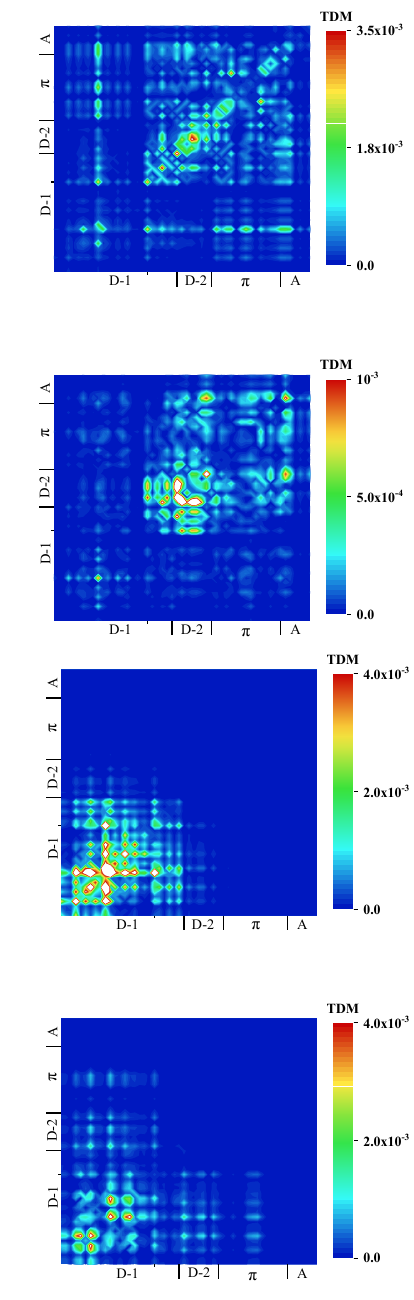
Figure 9. TDM and CDD of WS5 in TPA. TDM and CDD of S 0 → S 4 ( a ) of WS5, TDM and CDD of S 4 → S 17 ( b ) of WS5, TDM and CDD of S 0 → S 5 ( c ) of WS5, TDM and CDD of S 5 → S 18 ( d ) of WS5. As for the second step, S 4 → S 17 , it can be seen from Figure 9b that there was charge transfer between these four parts, among which the charge transfer between triphenylamine The TPA spectrum of WS6 had many absorption peaks, and its absorption range was and the π -linker and A was relatively weak. The CDD showed a blue isosurface on relatively wide. S 12 and S 9 , which constituted the strongest absorption peak, and S 4 , which the π - linker and A and a green isosurface on the triphenylamine, while the inserted D had a larger absorption cross-section, were mainly analyzed. For the excited state of S 4 , it (thiazolo[5,4-d]thiazole) was blue-green, indicating that the electron transfer from the π - had S 1 and S 3 as intermediate states. According to the previous analysis, the first step of linker and A to thiazolo[5,4-d]thiazole and then to triphenylamine was a sequential charge transfer. The second process was the reverse transfer of electrons, which was opposite to the first channel, S 0 → S 1 , was mainly the charge transfer in the A direction. The second the direction of charge transfer in the first process, indicating that the two-photon excited process was the reverse transfer of electrons to triphenylamine, as shown in Figure 10a. state of S 17 was a locally excited state. The TDM and CDD of S 18 are shown in The TDM indicated that the inserted D (bithiophene) not only had charge transfer with the π -linker, but also with the benzene ring on the inner side of triphenylamine. The CDD showed that the isosurface of the charge on the benzene ring on the inner side of triphenyl- amine was particularly large, and the isosurface of the inserted donor (bithiophene) was blue and green. Combined with the TDM, it was shown that electrons on the benzene ring were not only derived from the π -linker, but also from the bithiophene, and the electrons were transferred from the π -linker to the bithiophene and then to the benzene ring, the internal mechanism of which was the sequential charge transfer. The first step of the other pathway was from S 0 to S 3 . Both the π -linker and the A showed obvious local excitation and electron transfer excitation from the D to the A, as shown in Figure 10b. The second process of the second path was very similar to the first path in that electrons were transferred in reverse from the recipient to the donor, and the internal mechanism was sequential transfer, as shown in Figure 10c. By comparing the two paths, it was found that the excitation mode of the two paths was the same, and they were all local excitation on the whole, so the excited state was a local excitation. It is noteworthy that the intermediate state of S 9 and S 12 was also S 3, and Table 4 shows their transition dipole moments. The transition dipole moment from S 3 to S 12 was rela- tively large, indicating that the transition probability of this process was relatively large. The CDD and TDM of the two processes of S 3 → S 12 and S 3 → S 9 are shown in Figure 10d,e. First, the S 3 → S 12 process exhibited local excitation on the π -linker and A and generated charge transfer with the two donors, as shown in the TDM of Figure 10d. It can be demon- strated from the CDD that electrons were mainly transferred from the π -linker to the two donors, which was different from the sequential charge transfer of S 3 → S 4 . Another differ- ence was that the hole isosurface on the A was relatively small, indicating a relatively weak degree of charge transfer.